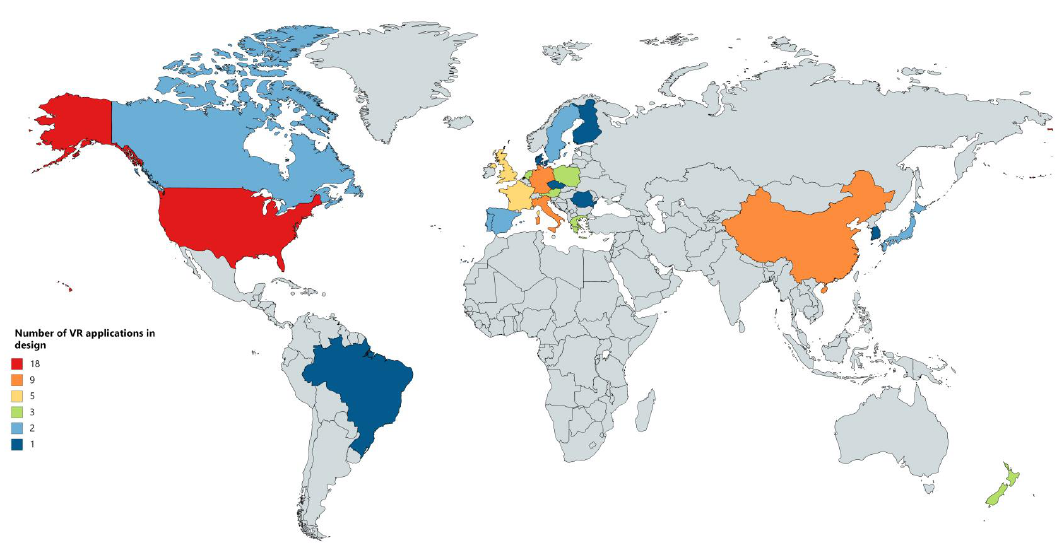
Figure 2. Number of gathered sources describing VR applications in design grouped in terms of the first affiliated country of corresponding authors.